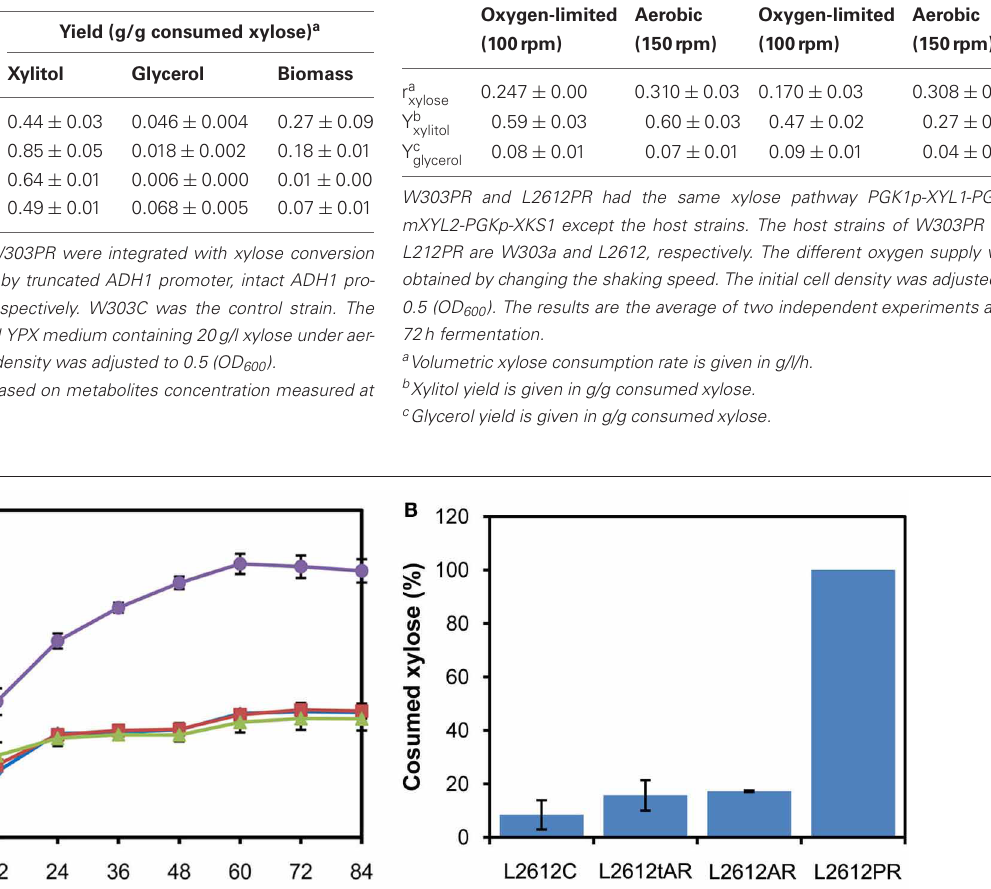
integrated with xylose conversion pathway with XYL1 controlled by truncated ADH1 promoter, full-length ADH1 promoter and PGK1 promoter in yeast L2612. L2612C was the control strain. Xylose uptake capacities are presented as the percentage of consumed xylose after 72h. The results shown were the mean value of duplicate